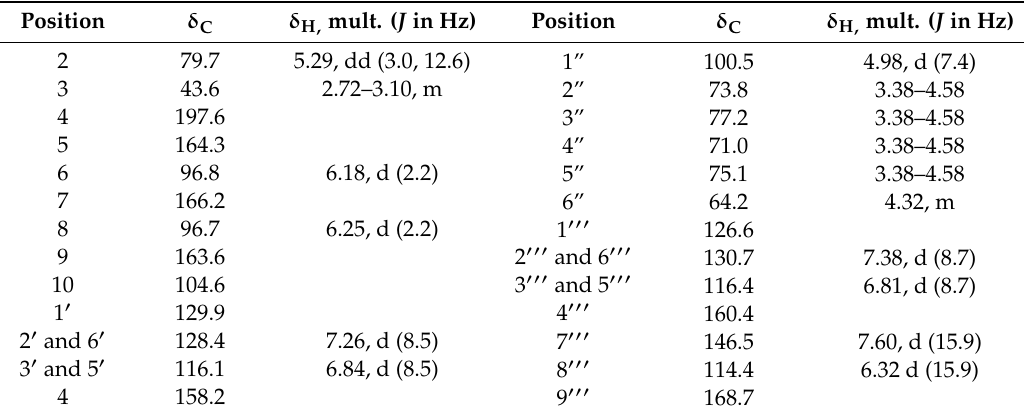
Table 3. 1 H and 13 C-NMR spectroscopic data of compound 4 in CDCl 3 .